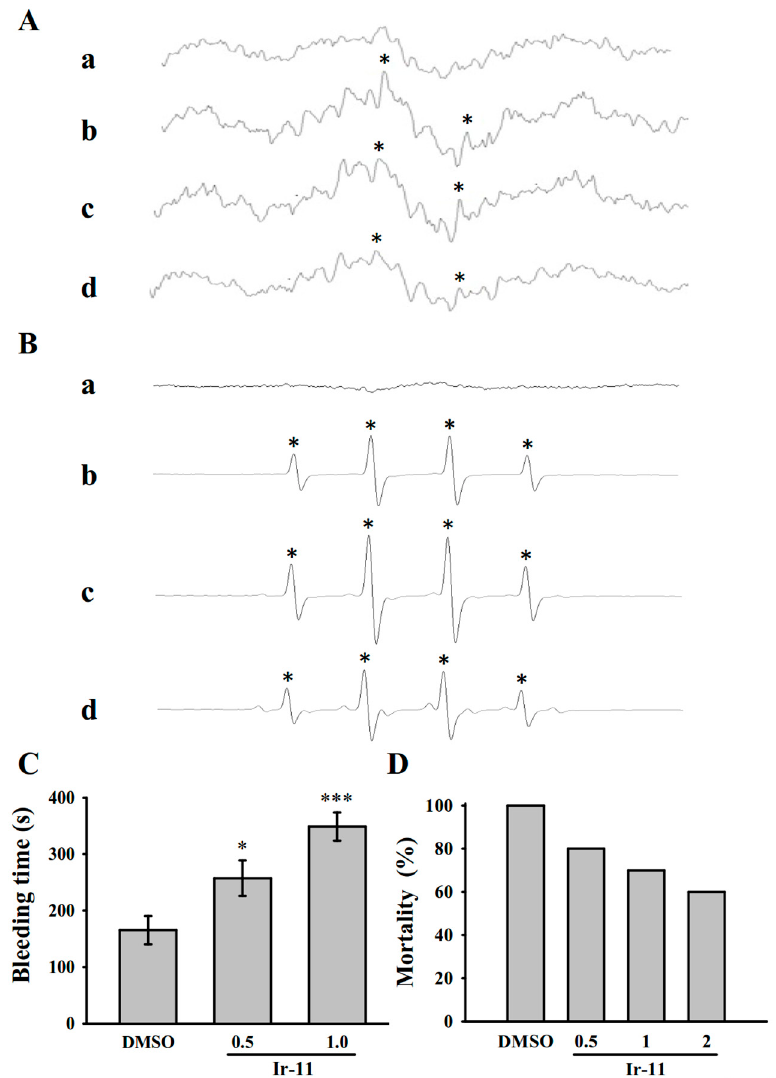
Figure 6. Regulatory activities of Ir-11 on OH · formation in platelet suspensions or the Fenton reaction solution, and bleeding time in the tail vein as well as acute pulmonary thromboembolism in experimental mice. ( A ) Washed platelets or ( B ) the Fenton reaction solution was preincubated with Tyrode solution ( a , resting control), ( b ) 0.1% DMSO, or Ir-11 at ( c ) 6 µM or ( d ) 10 µM. Collagen (1 µg/mL) was then added for the ESR experiments as described in Materials and Methods . Profiles